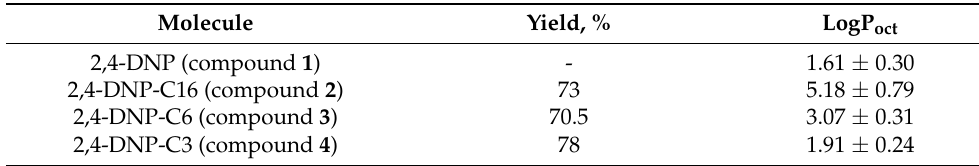
Table 3. 2,4-DNP derivatives characterization.